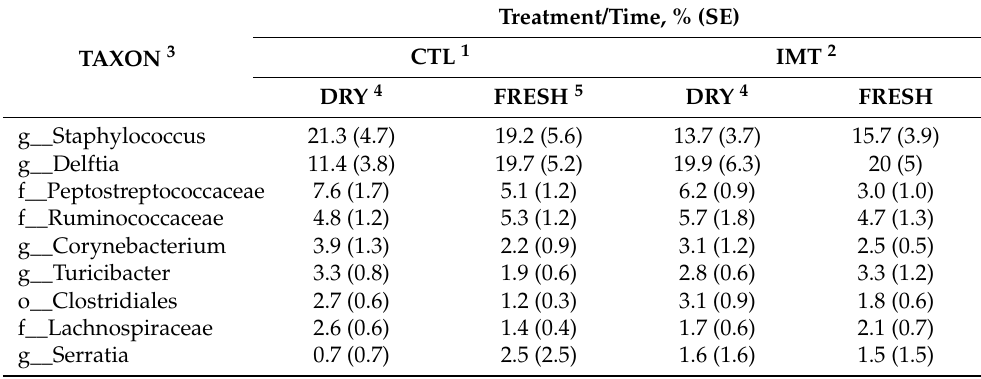
Table 1. Relative abundances for the top 20 taxa observed by treatment group and sampling point. TAXON 3